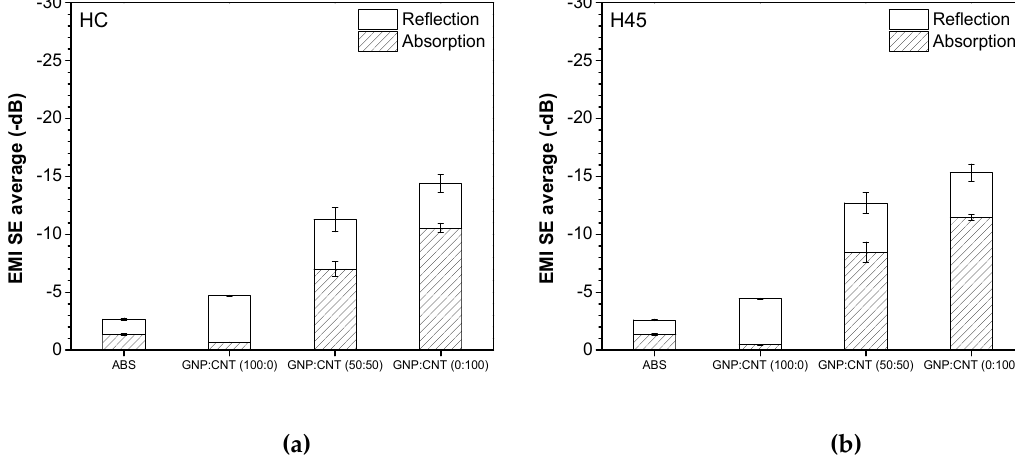
(b) (c) Figure 9. Representative curves of EMI SE of hybrid nanocomposite samples produced by FFF three- dimensional (3D) printing: ( a ) HC, ( b ) H45, and ( c ) PC.